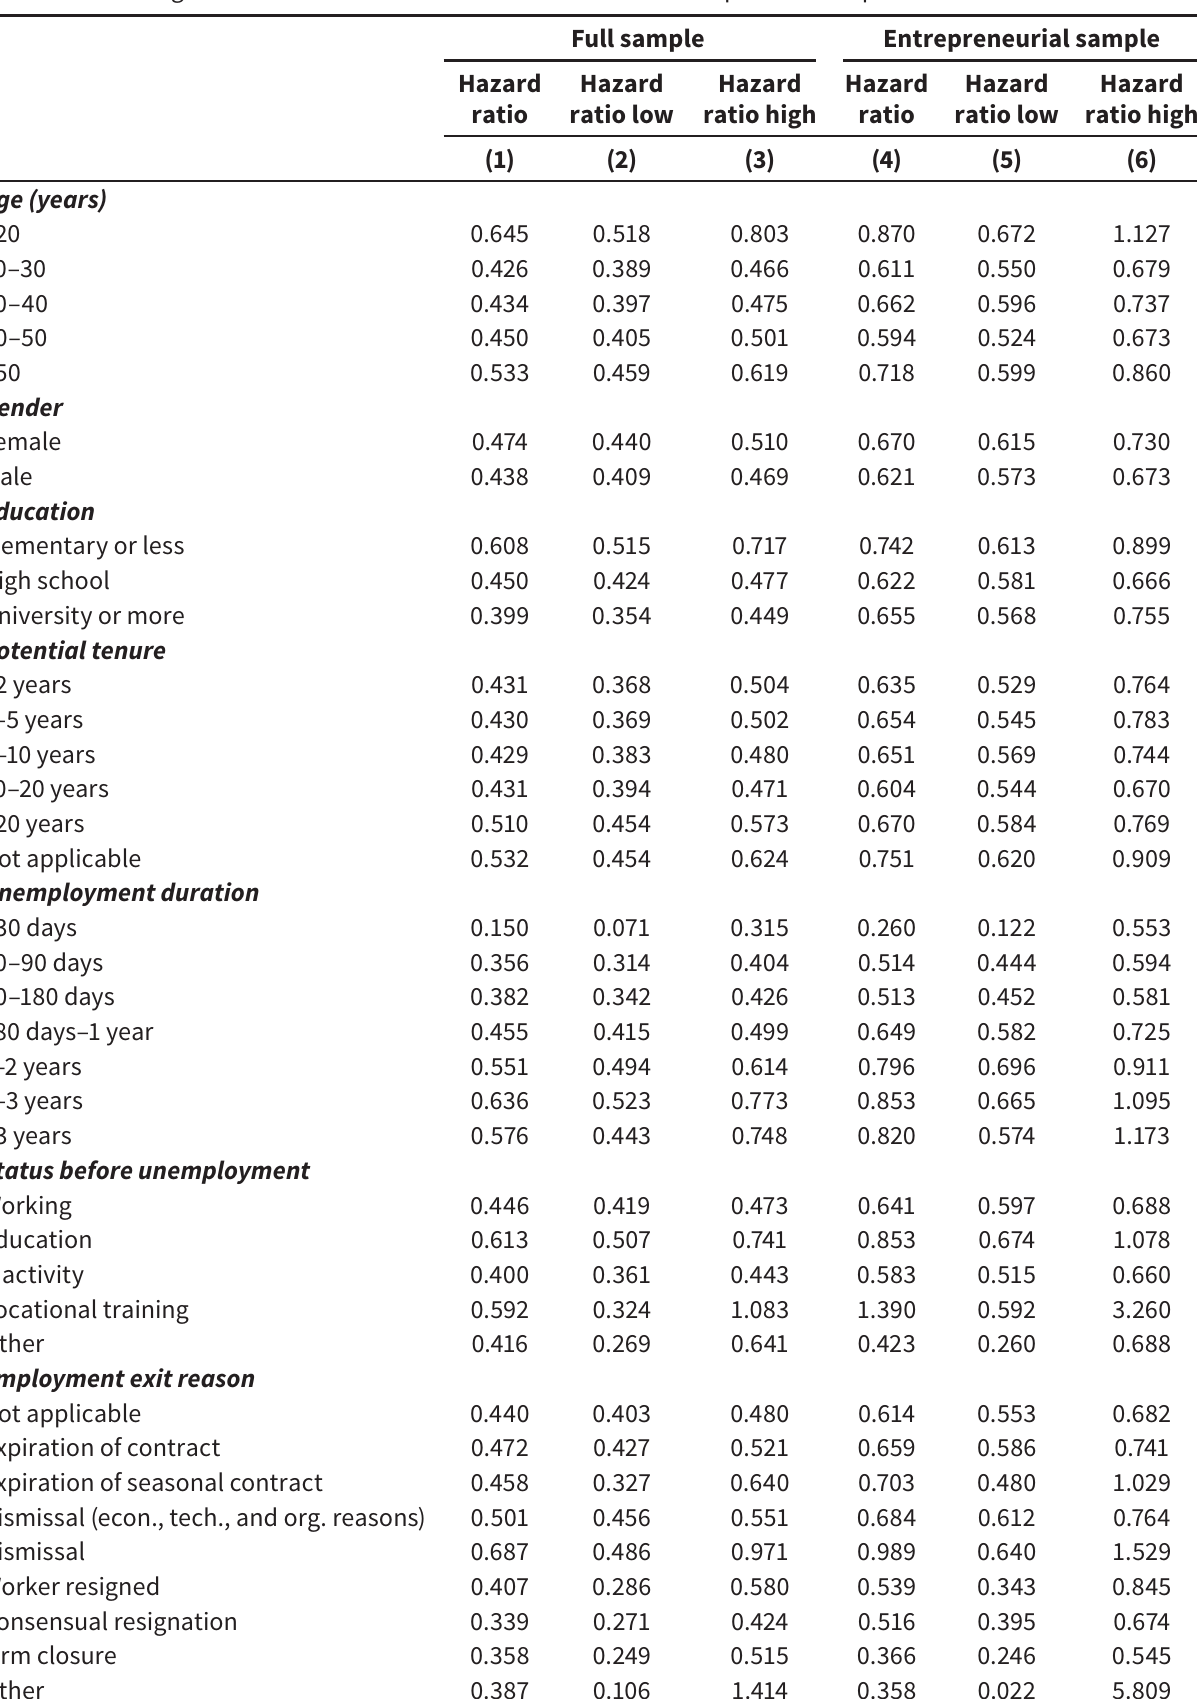
Heterogeneous effects: COX PH model with the most comprehensive